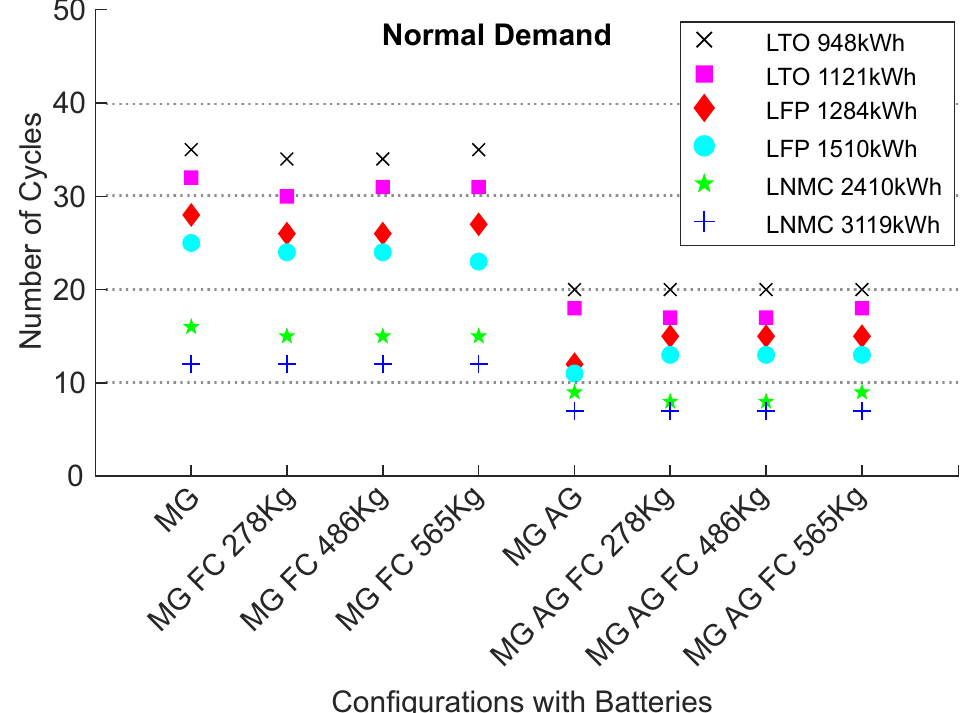
Figure 11. Number of cycles that each battery required in each configuration for normal